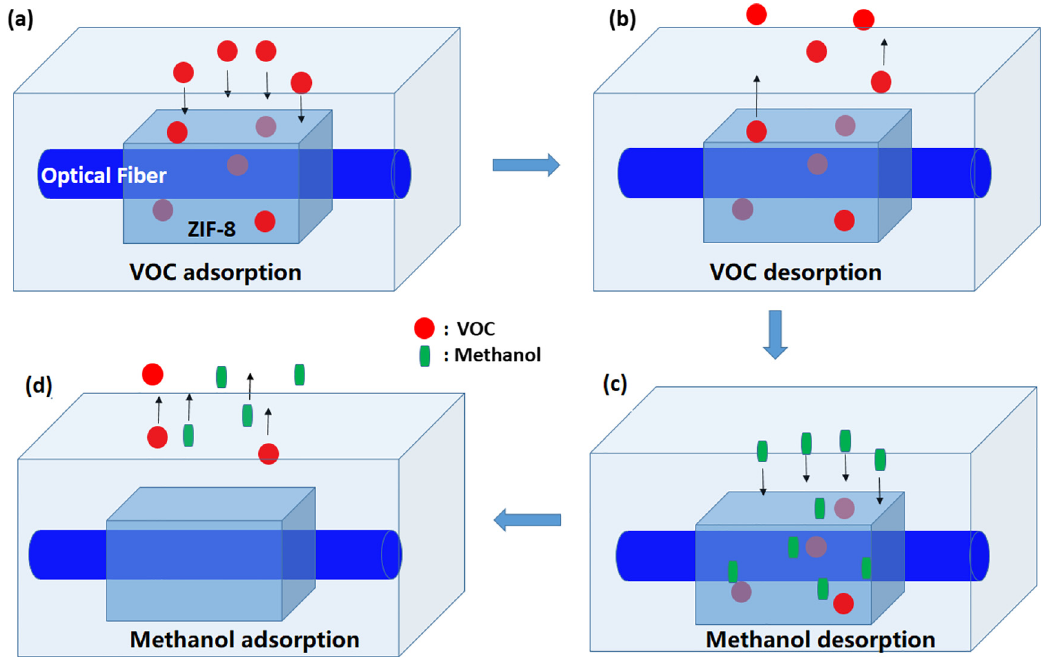
Figure 3: The setup of volatile organic compound (VOC) adsorption and desorption in zeolitic imidazole frameworks (ZIF)-8. (a) Adsorption: Charge VOC; (b) desorption: Open the chamber; (c) adsorption: Charge methanol; (d) desorption: Open the